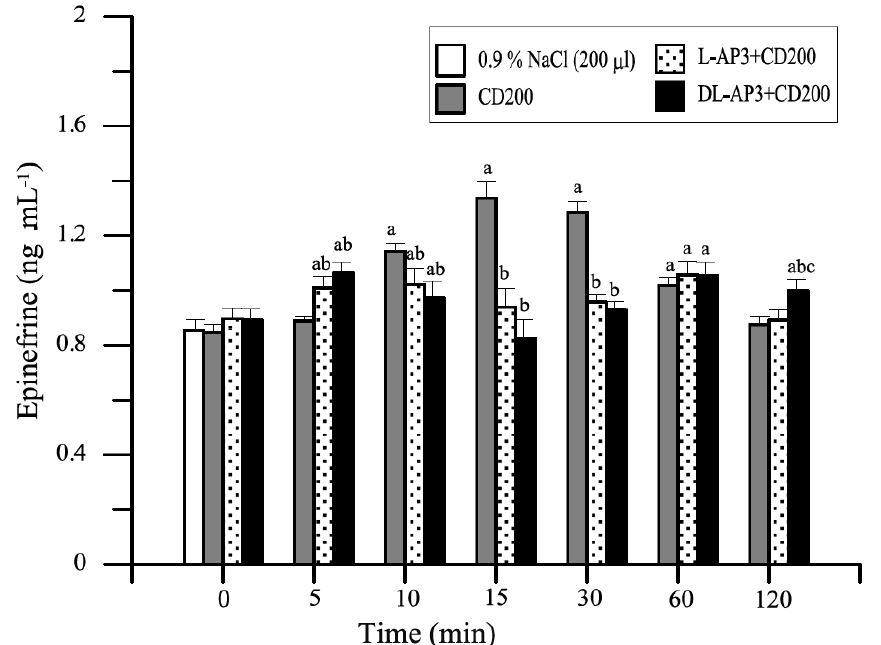
Figure 13. Summed from three doses, mean changes in plasma cortisol levels (ng·mL − 1 ) in the test groups of animals. Control group (200 µL of 0.9% NaCl), RO200, and after ICV infusion 10 min premedication with three different doses of L-AP 3 (0.2, 0.4, and/or 0.8 mg in toto) and DL-AP3 (2, 4, and/or 8 mg in toto) in the RO200 test within 120 min of com- pleting the RO procedure (mean ± SD, n = 6) [34]. Key: a—significant differences ( p ≤ 0.05) compared with the value of 0.9% NaCl; b—significant differences ( p ≤ 0.05) compared with the value of the RO200 group; c—significant differences ( p ≤ 0.05) between the L-AP 3 and DL-AP 3 groups .